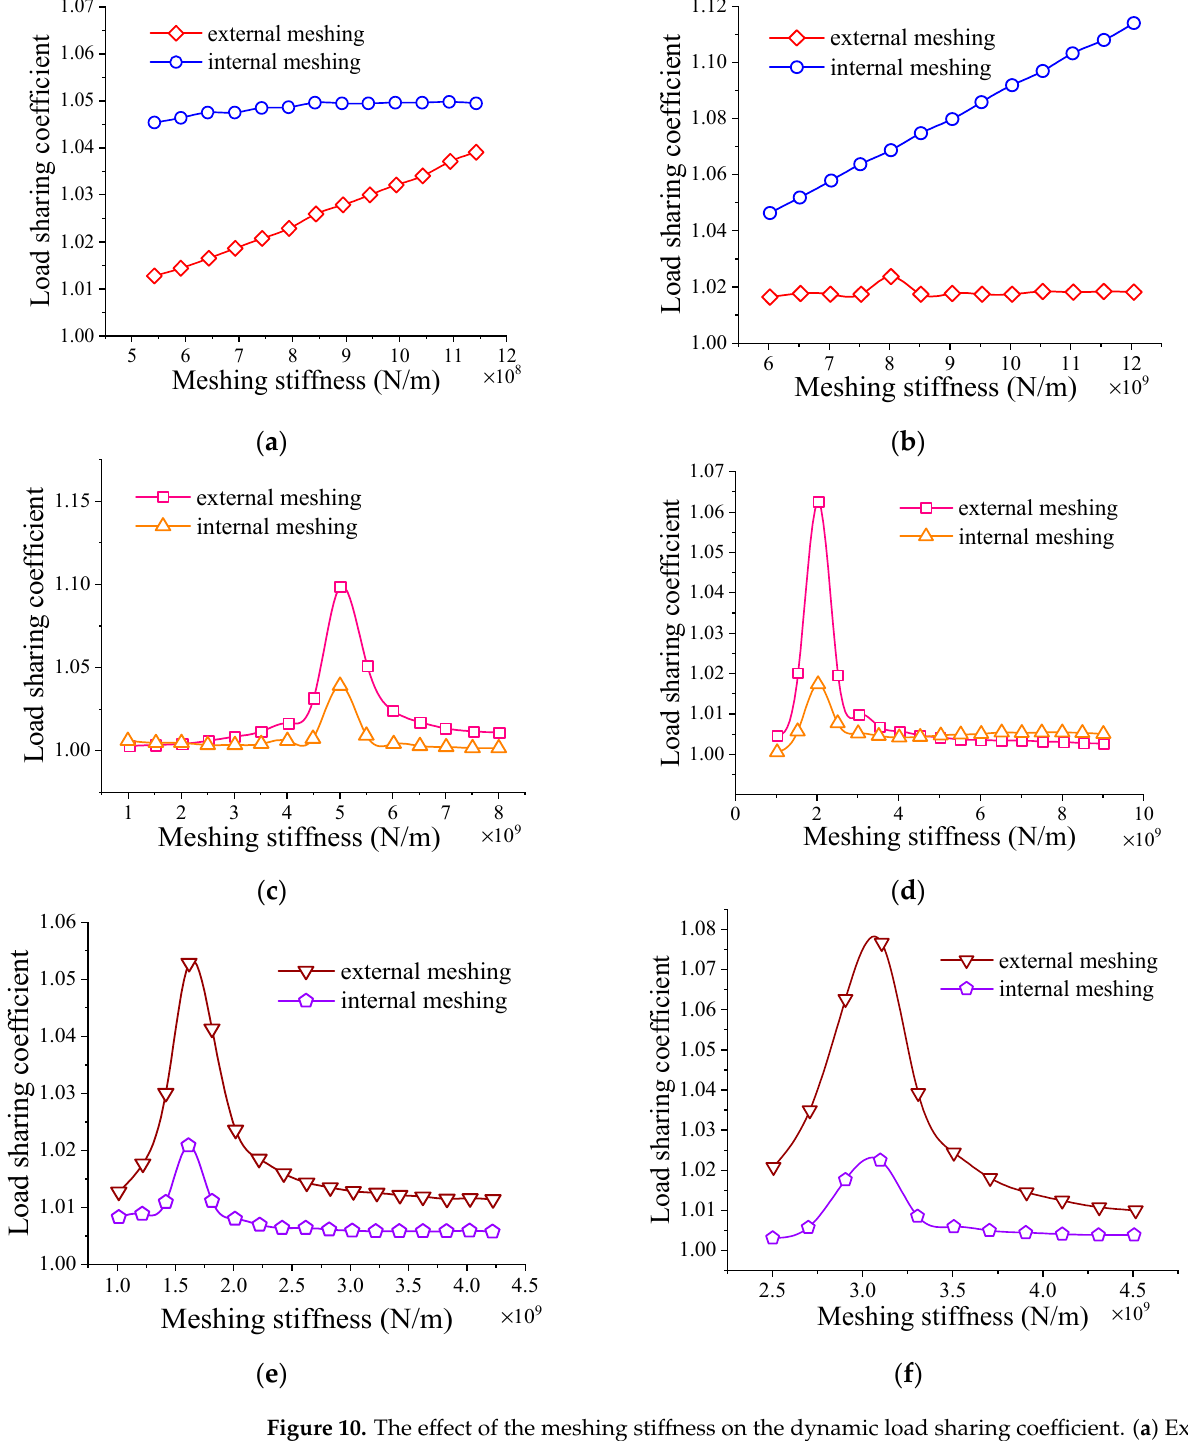
Figure 10. The effect of the meshing stiffness on the dynamic load sharing coefficient. ( a ) External meshing stiffness in the first stage; ( b ) internal meshing stiffness in the first stage; ( c ) external meshing stiffness in the second stage; ( d ) internal meshing stiffness in the second stage; ( e ) external meshing stiffness in the third stage; ( f ) internal meshing stiffness in the third stage.